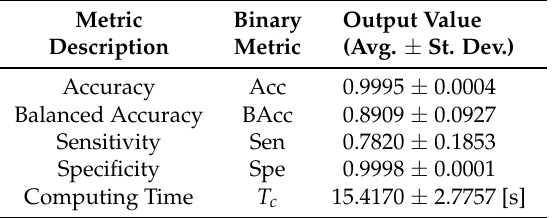
Table 2. Quantitative evaluation of the microaneurysm detection.